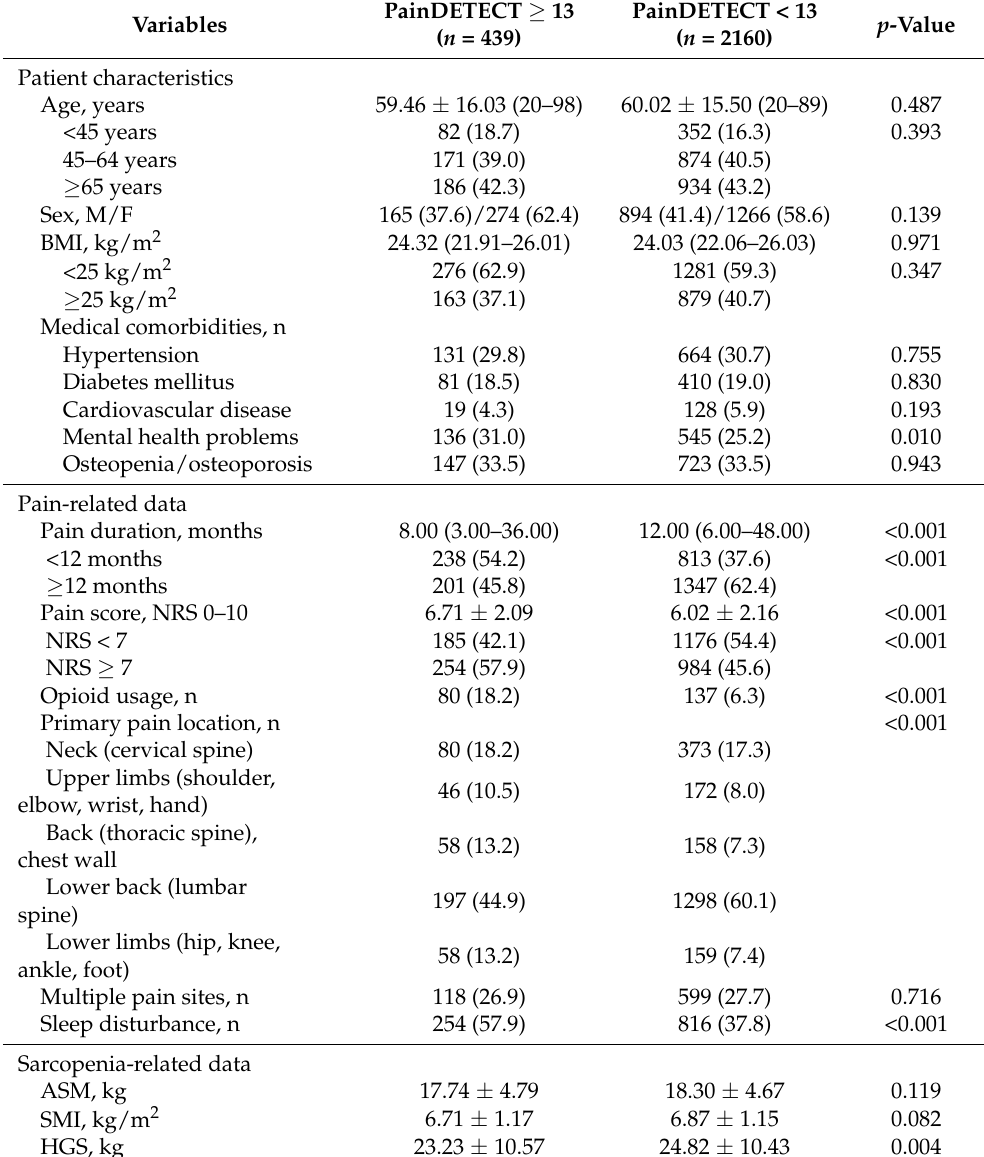
Table 1. Characteristics, pain-related data, and sarcopenia-related data between patients who reported a painDETECT score ≥ 13 (possible neuropathic-like pain symptoms) and those with a painDETECT score < 13 in patients with chronic musculoskeletal